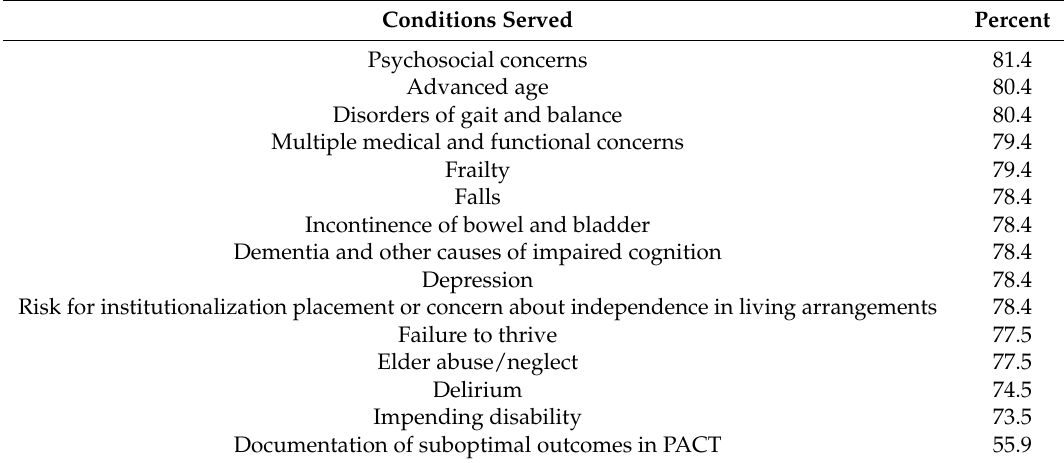
Table 4. Patient Conditions served in GeriPACT (N =